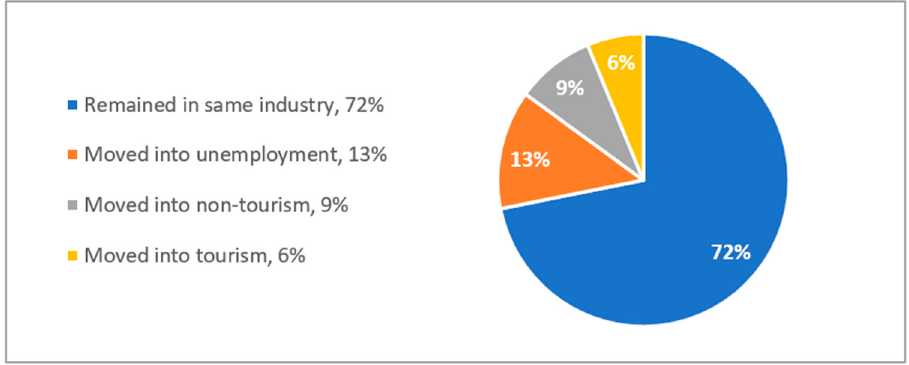
Figure 4. Movement between industries ( n =